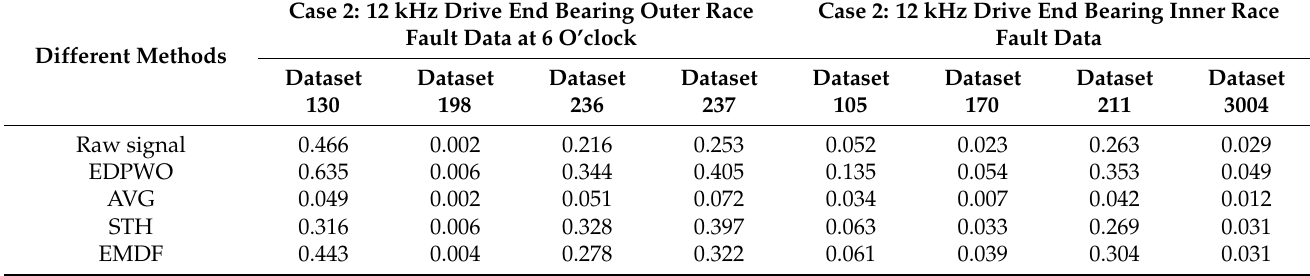
Different Methods